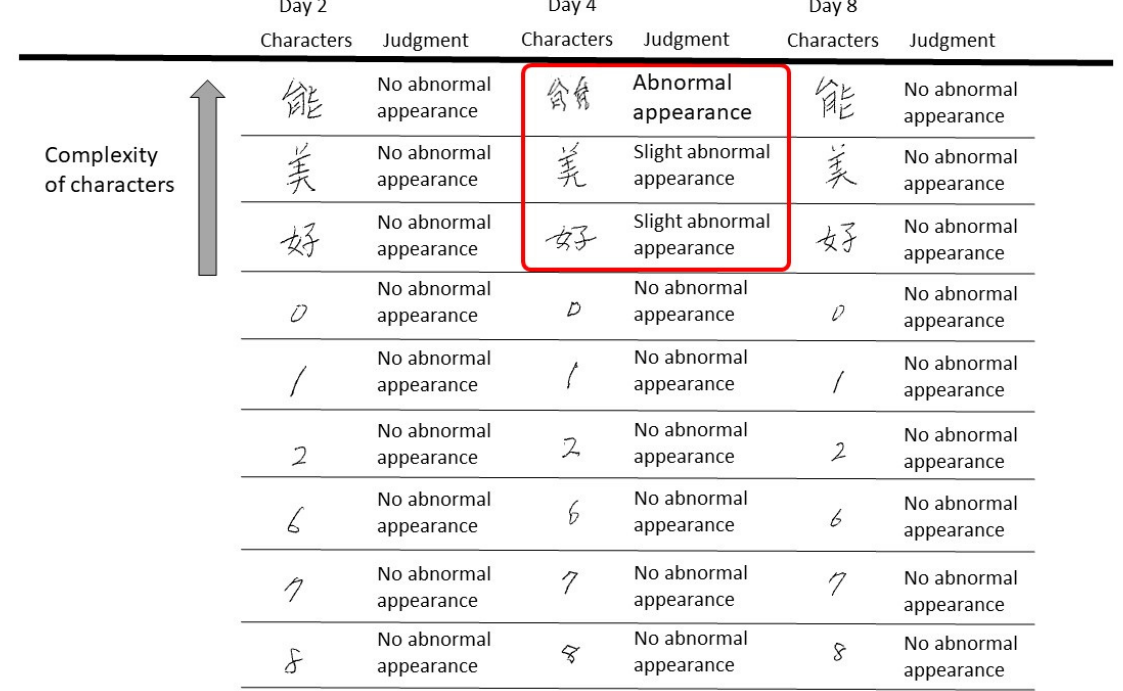
Figure 6. Evaluation of dysgraphia based on the complexity of characters. For numbers comprising relatively simple lines or circles, the severity of dysgraphia was low. It is not easy to determine whether the writing disorder occurred on the fourth day. Kanji characters with complex lines are more likely to show dysgraphia.